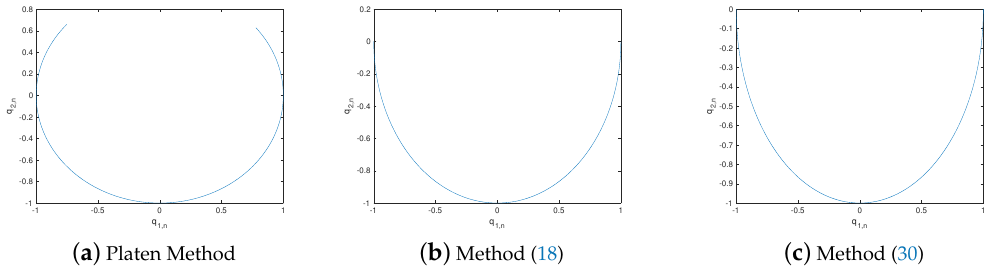
Figure 5. Numerical sample paths of the Platen method, method (18), and method (30).